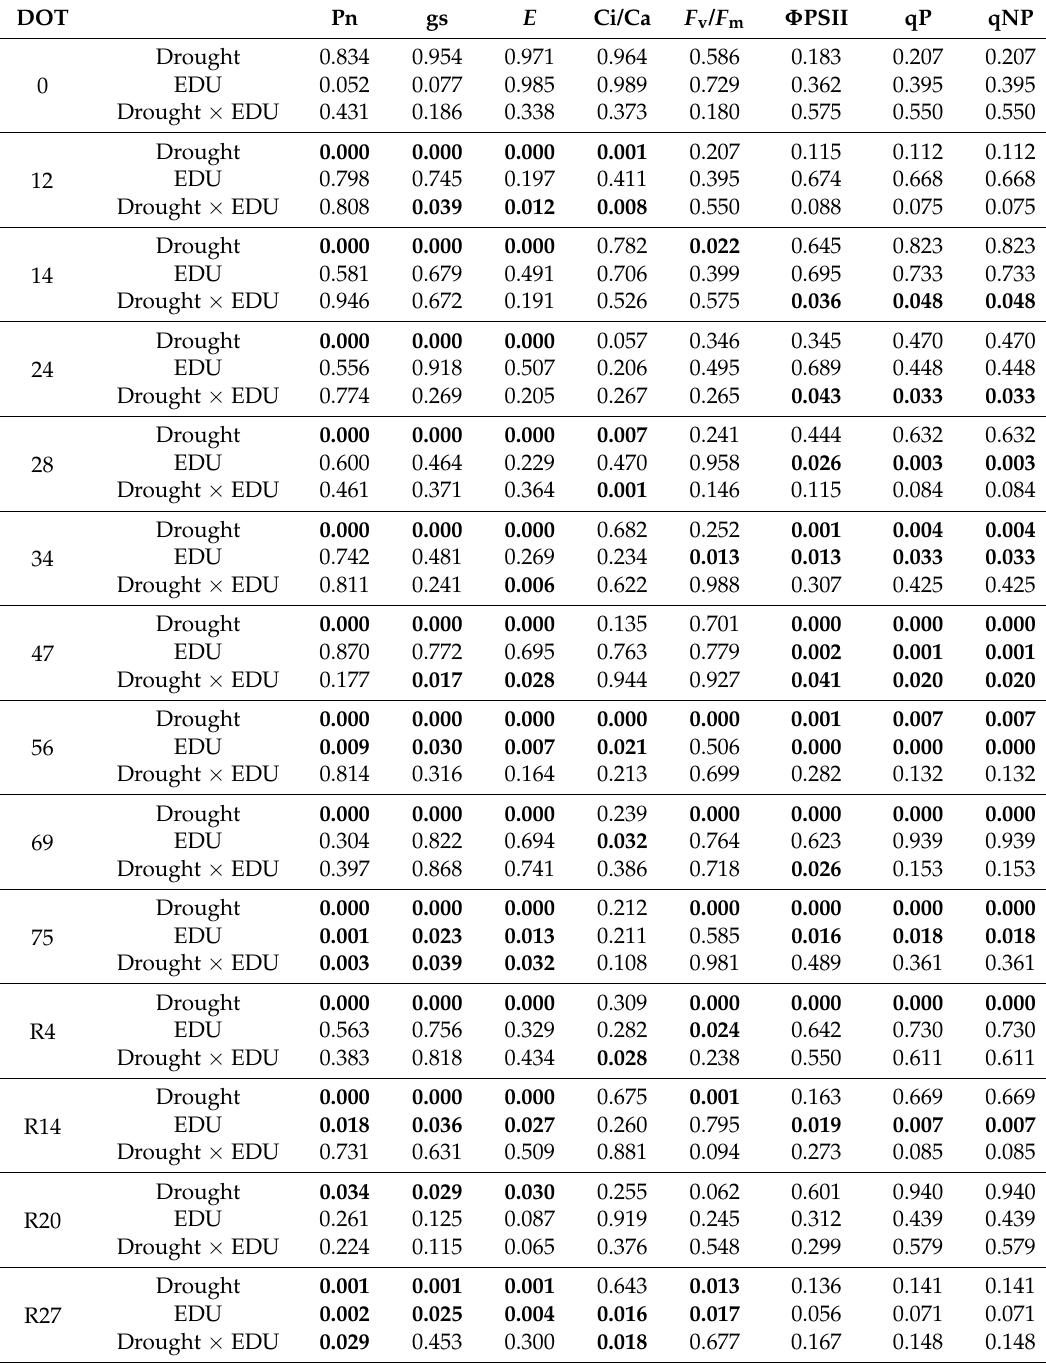
Table 2. Analysis of Variance for the parameters derived from gas exchange and chlorophyll fluorescence measurements. Pn = net photosynthesis; gs = stomatal conductance; E = leaf transpiration; Ci/Ca = ratio between substomatal and ambient [CO 2 ]; F v / F m = maximum quantum yield of